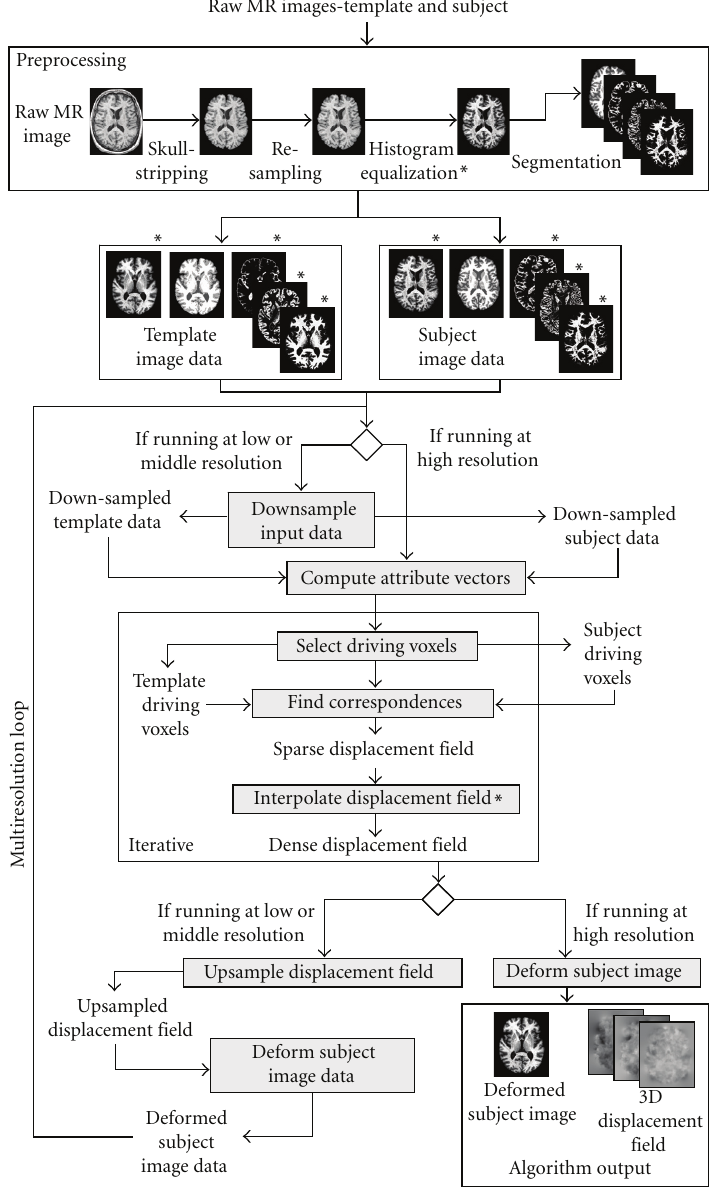
Figure 1: A flowchart demonstrating the major steps of Mjolnir. Elements of Mjolnir that are di ff erent from HAMMER are marked with ∗ .